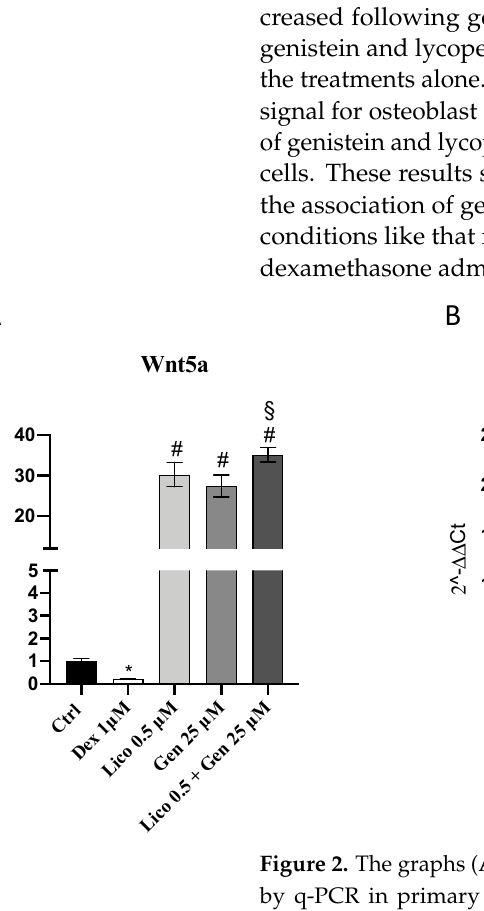
Figure 2. The graphs ( A – C ) represent Wnt5a, β -Catenin, and Sclerostin mRNA expression evaluated by q-PCR in primary osteoblasts treated with lycopene or genistein or lycopene and genistein following dexamethasone challenge for 24 h. The data are expressed as means and SD. * p < 0.0001 vs. Ctrl; # p < 0.0001 vs. Dex; § p < 0.0001 vs lycopene and genistein.